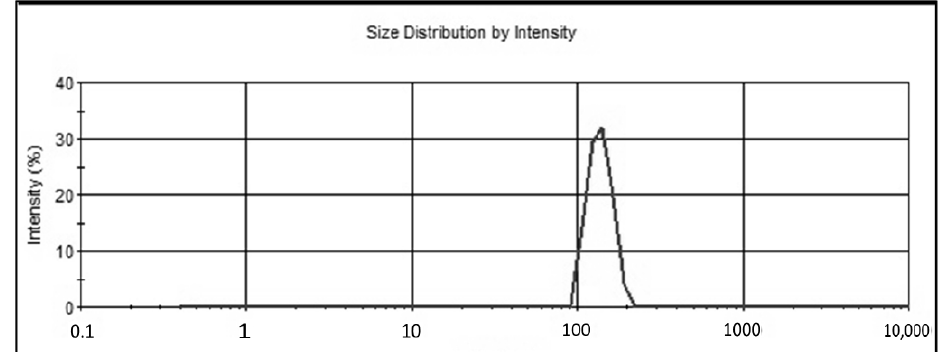
Figure 1. Vesicle size image of chitosan-coated PPN liposomes (PL3C1).